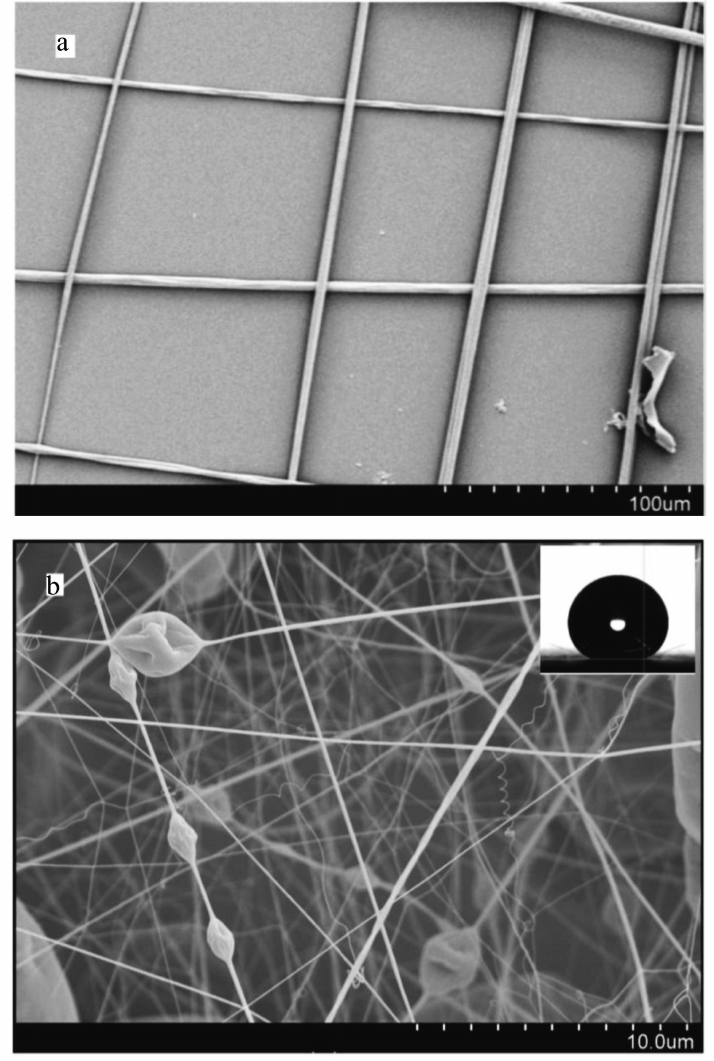
Figure 16. SEM images of 18% weight Polystyrene fibers with 1% weight fluoro-elastomer. ( a ) Grid-like structure of a mono-layer; ( b ) Several layers of fibers show random orientation. Upper right inset in ( b ) shows a water droplet on top of this particular coating. Adapted from Samaha et al.